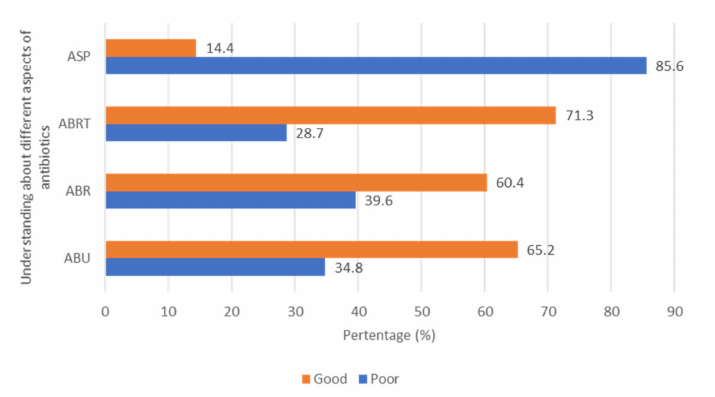
Figure 1. Understanding of respondents regarding ABU (antibiotic use), ABR (antibiotic resistance), ABRTs (antibiotic resistance terminologies), ASP (antimicrobial stewardship